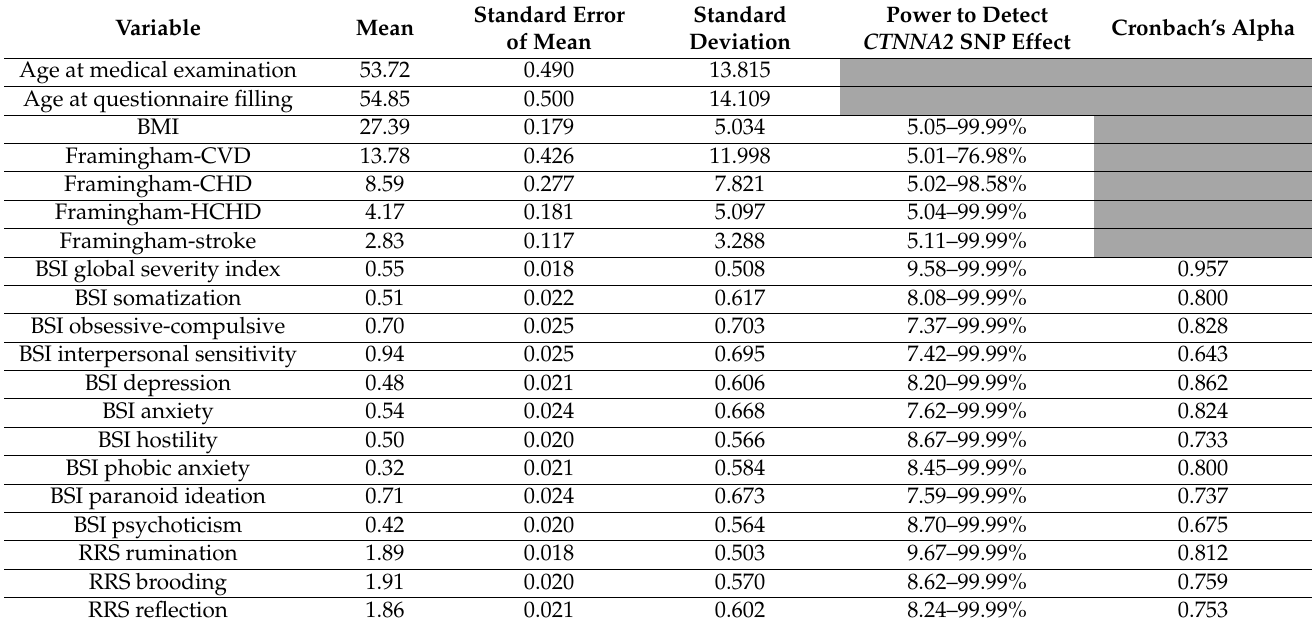
Table 1. Descriptive statistics for the measures of our study ( n = 795). Range of Framingham scores can be between 0 and 100%, BSI scores can range from 0 to 4, and RRS scores from 1 to 4. The results suggest that our study sample is generally overweighted and has an intermediate risk for CVD, but a low risk for specific CVD diseases. We can also see a wide range of statistical power values to detect CTNNA2 SNP effects on all phenotypes, and good internal consistencies for psychometric